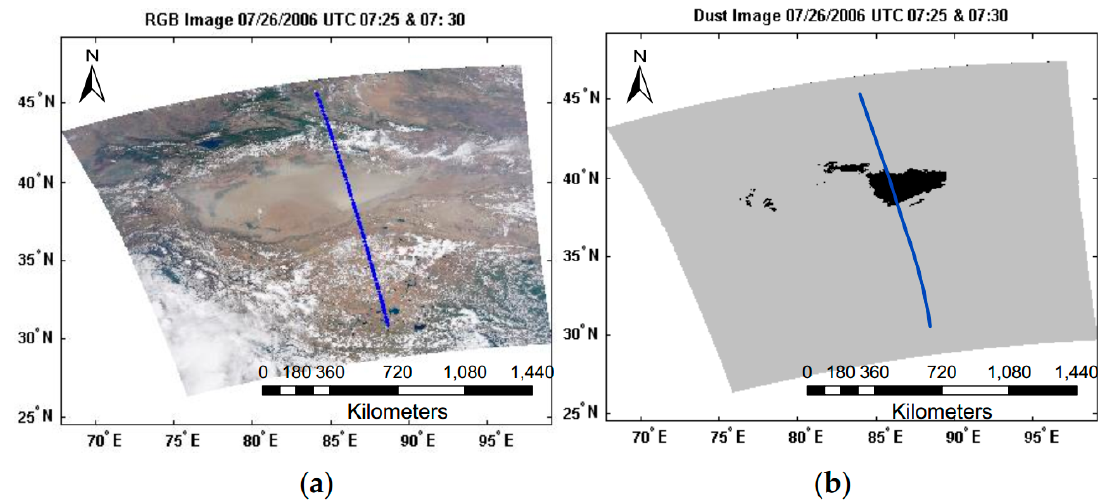
Figure 10. ( a ) The MODIS true color image of the dust storm over the Taklimakan Desert on 26 July 2006. The blue solid line is the footprint of CALIOP (Cloud-Aerosol Lidar with Orthogonal Polarization); ( b ) The dust image of the dust storm in the Taklimakan Desert on 26 July 2006.